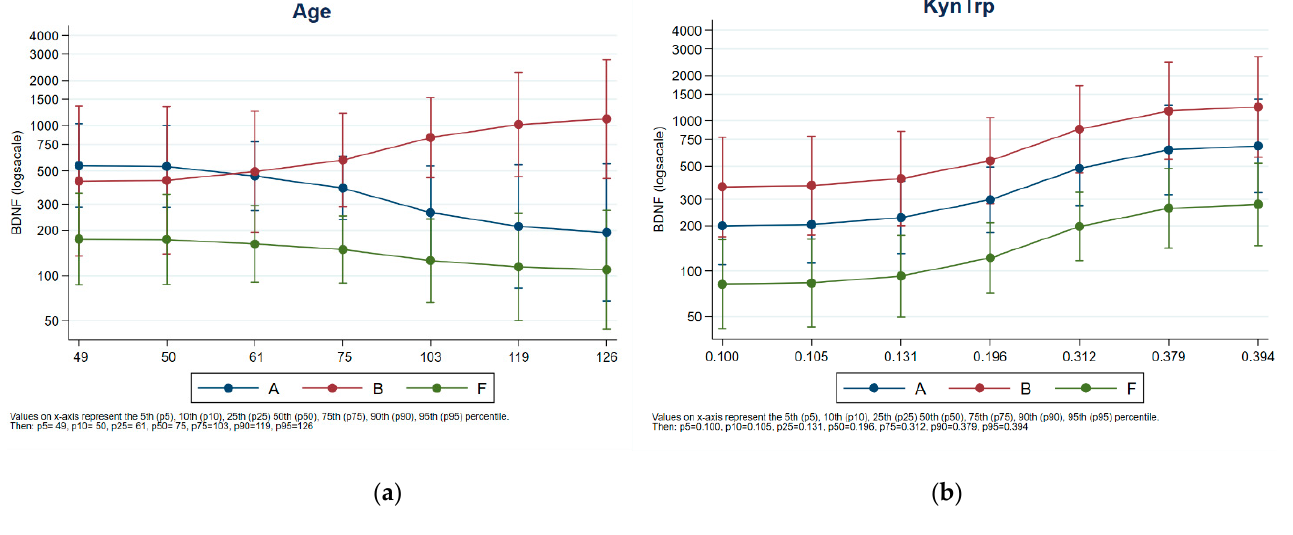
Figure 3. Effect of KYN/TRP ratio ( a ) and ages ( b ) on plasma BDNF levels. Blu Class: Housing-A; Red class: Housing-B. Green class: Housing-C.